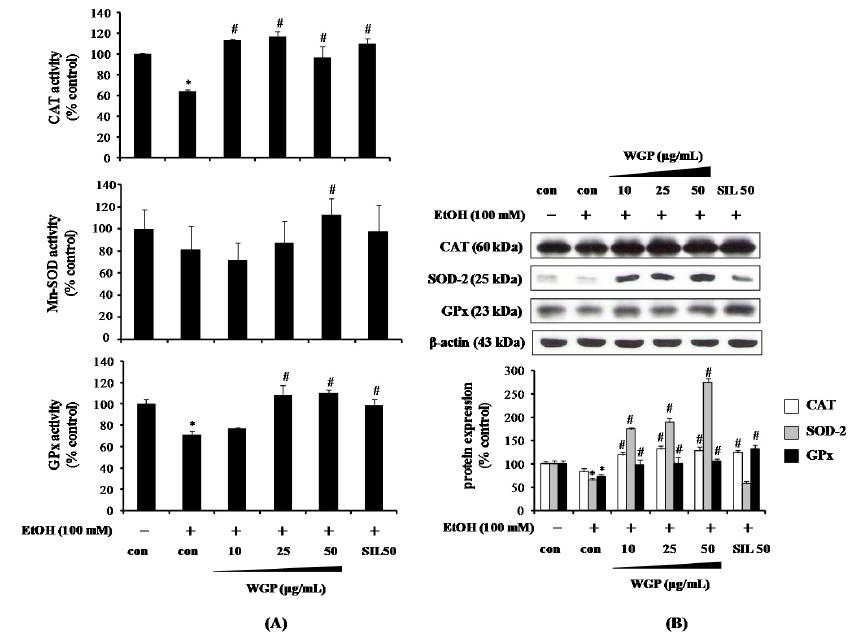
Figure 3. Effects of WGP on activity and protein expression of antioxidant enzymes in ethanol-treated HepG2 cells. ( A ) Activities of catalase (CAT), Mn-SOD, and glutathione peroxidase (GPx); and ( B ) protein levels of CAT, SOD-2, and GPx. Cells were pretreated with vehicle or WGP for 1 h before incubating with ethanol (100 mM) for 24 h. Data are the mean ± SD values of three individual experiments. * p < 0.05 indicates differences from the unstimulated-control group; # p < 0.05 indicates differences from the ethanol-treated group.